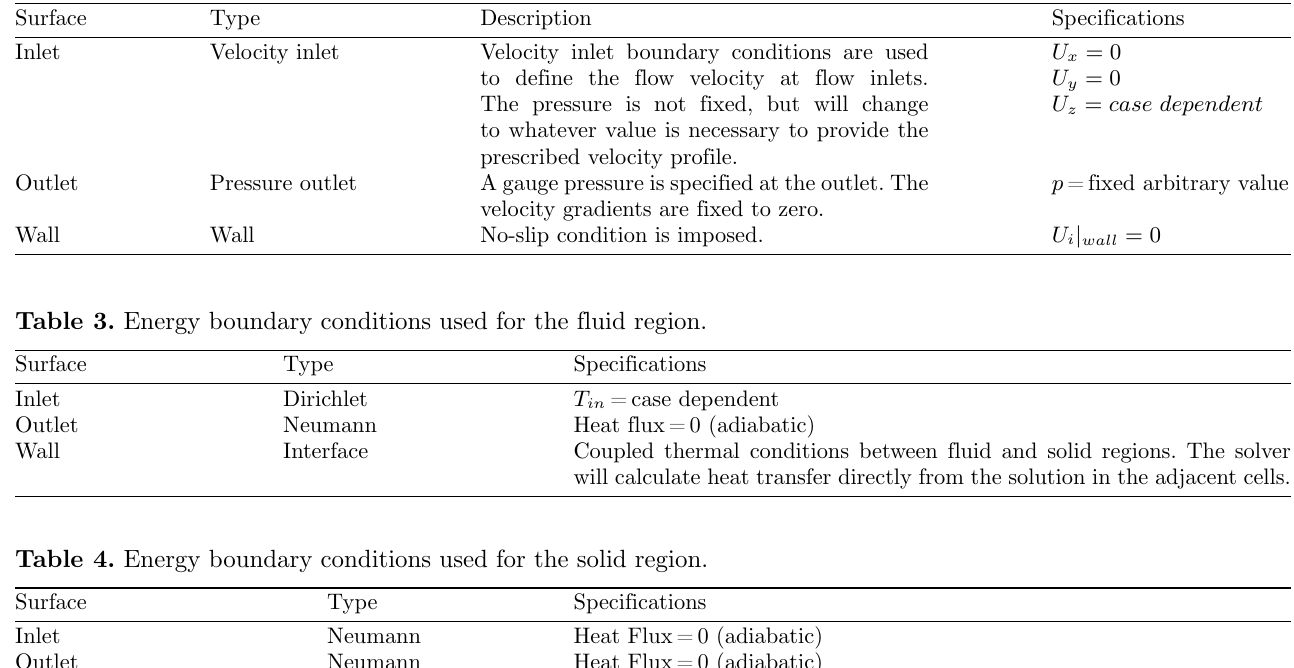
Table 2. Hydrodynamic boundary conditions used.